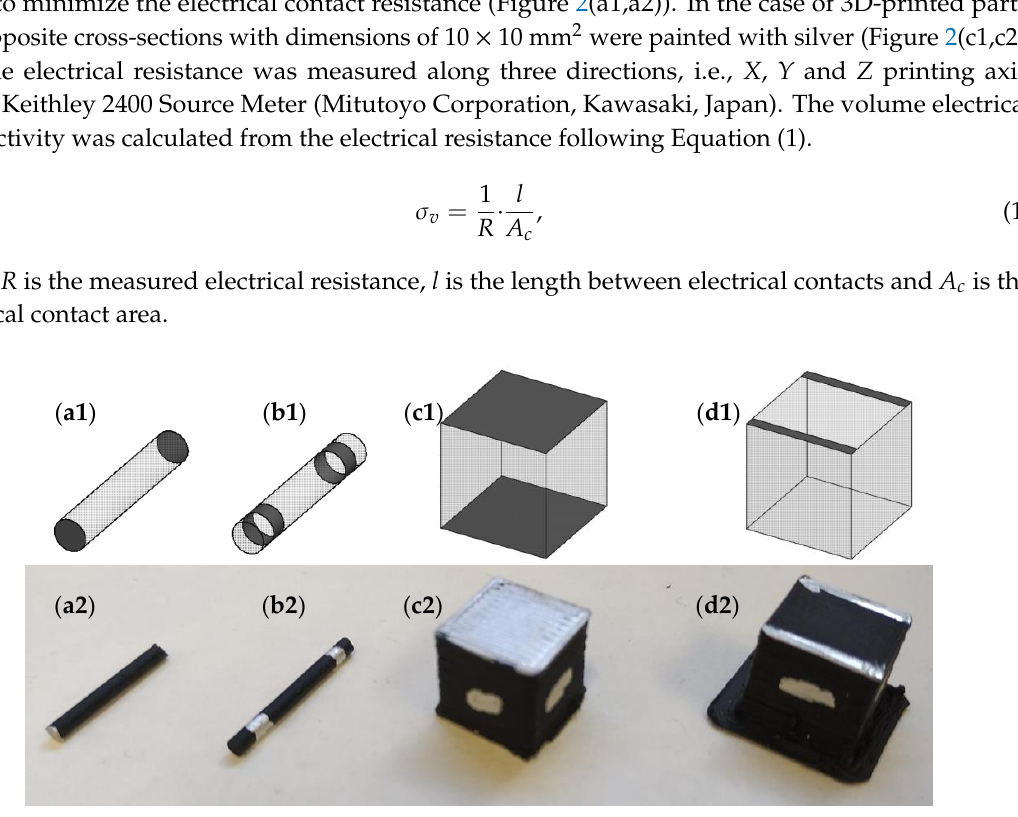
Figure 2. Samples for measurement of ( a , c ) volume and ( b , d ) surface electrical conductivity of: ( a , b ) filaments and ( c , d ) 3D printed parts (1 index: schematic representation; 2 index: real part).